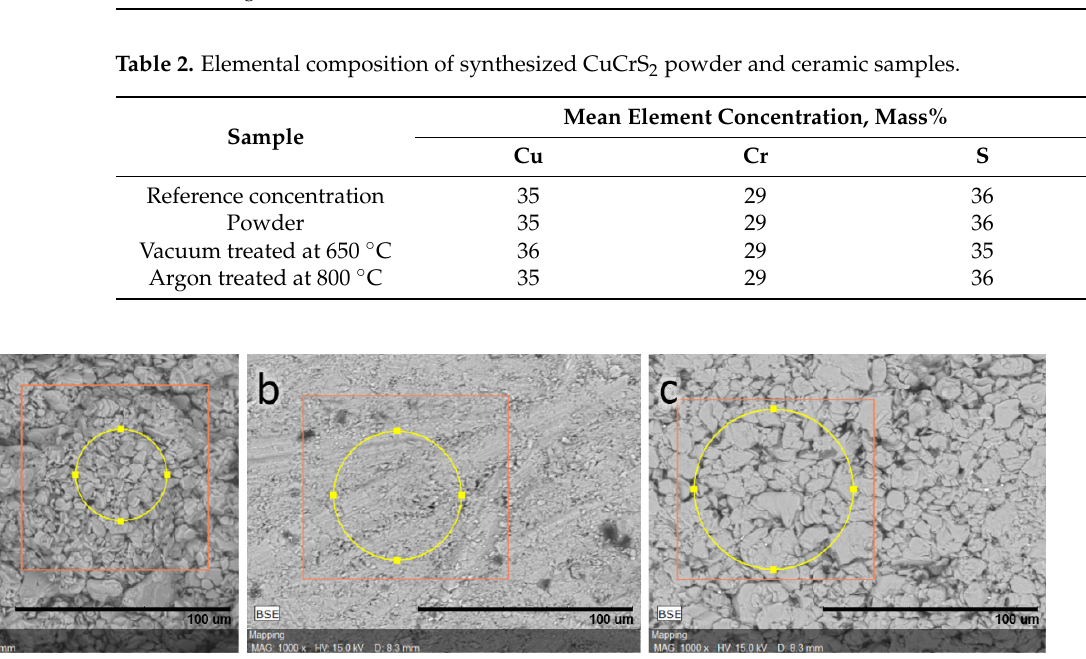
Figure 2. SEM images of CuCrS 2 samples: powder ( a ), vacuum compressed ( b ) and argon atmosphere treated samples ( c